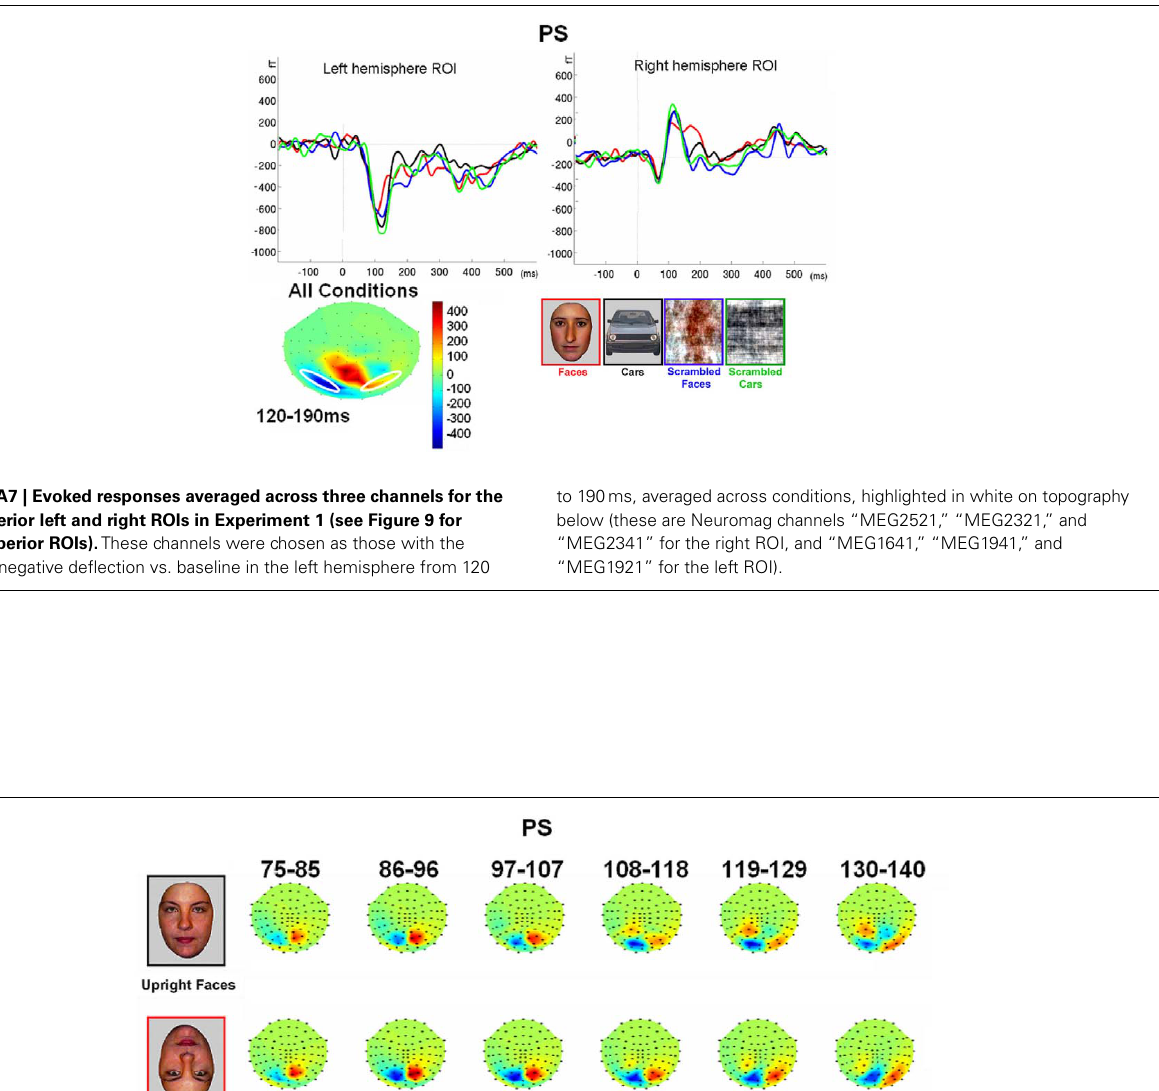
between sensors, indicated by black dots, after their spherical projection onto a 2D surface). Red and blue indicate outward and inward radial direction of magnetic flux through single flux coils within the helmet (in units of